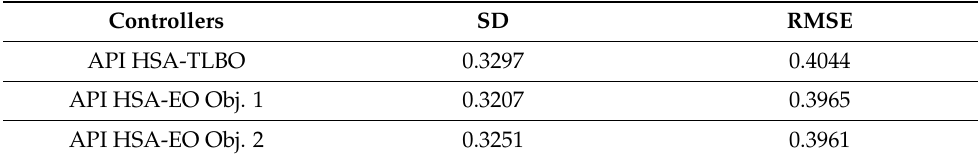
Table 4. Numerical comparison between the controllers at normal second case.